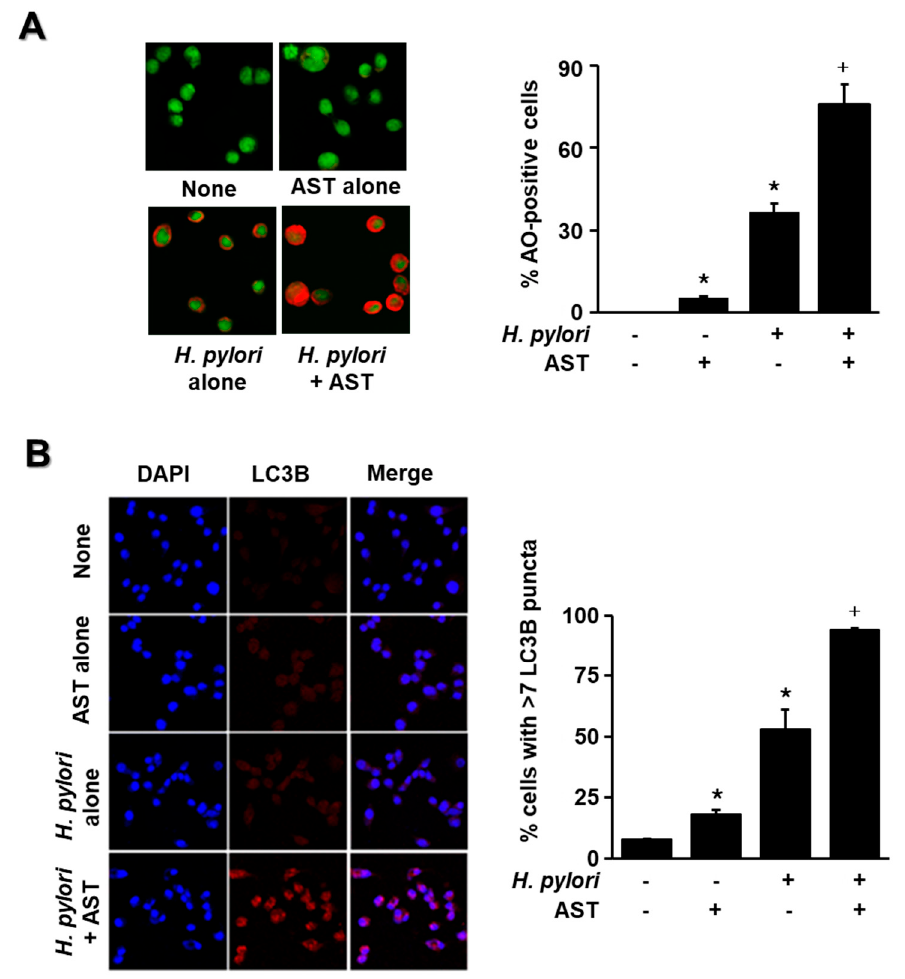
Figure 4. Effect of astaxanthin on autophagy activation in H. pylori -stimulated AGS cells. The cells were pre-treated with 50 nM astaxanthin for 3 h and then stimulated with H. pylori (cell to H. pylori ratio of 1:50) for 24 h. ( A ) Cells were stained with acridine orange (AO) dye and visualized under a confocal laser scanning microscope (left panel). AO-positive cells were quantified and expressed as % of cells with AO-positive cells/total number of cells (right panel). ( B ) The cells were stained with anti-LC3B antibody and rhodamine-labeled mouse anti-rabbit IgG antibody. Immunocytochemical staining for LC3B (red) and DNA counterstaining with DAPI (blue) are shown in the left panel. Each sample was analyzed using a threshold of >7 dots/cell. LC3B puncta-positive cells were quantified and expressed as % of cells with >7 LC3B puncta/total number of cells (right panel). * p < 0.05 vs. control (cells without H. pylori stimulation and without AST treatment); + p < 0.05 vs. cells with H. pylori stimulation and without AST treatment. Astaxanthin (AST).